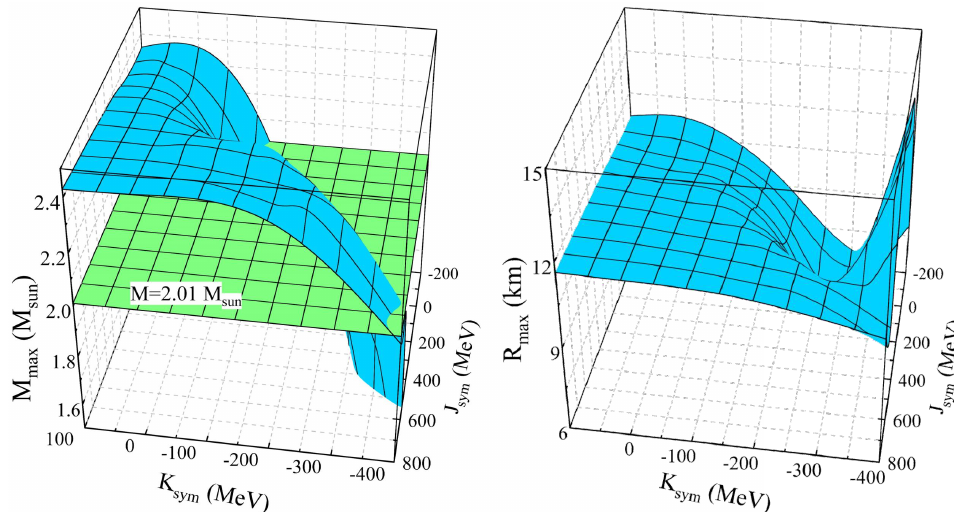
Figure 17. The maximum masses M TOV ( left ) and corresponding radii ( right ) of non-rotating NSs on the causality surface as functions of the curvature and skewness of nuclear symmetry energy. Taken from